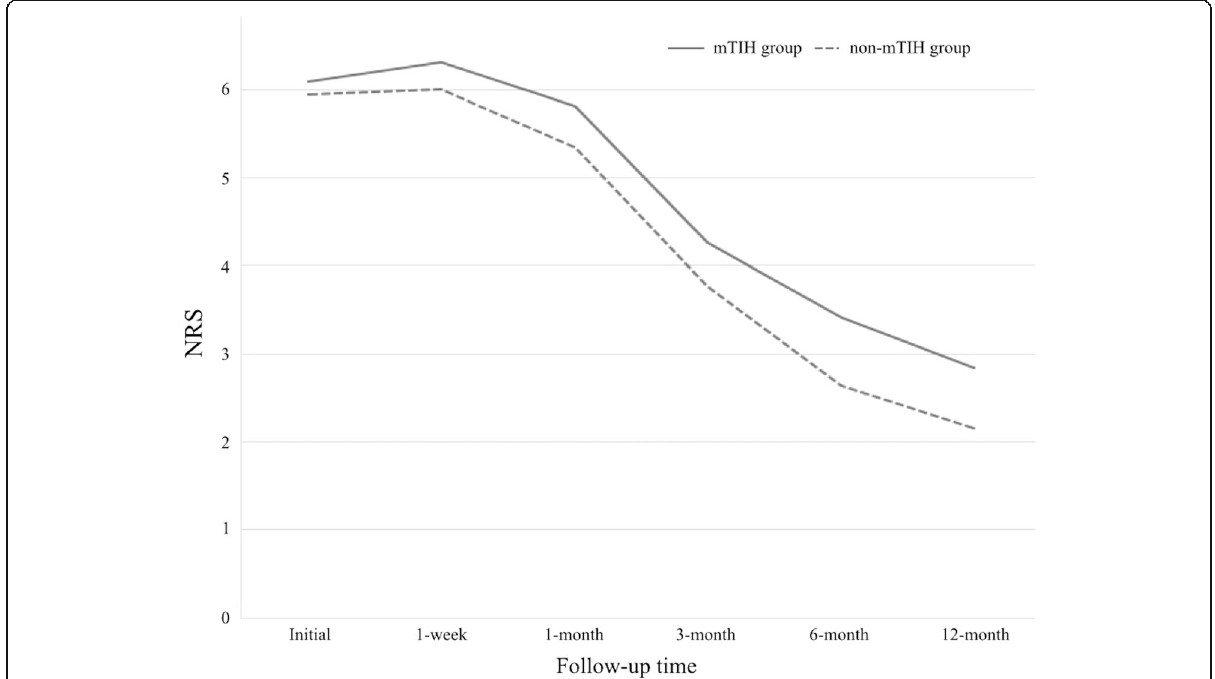
Fig. 2 Mean numeric rating scale (NRS) scores of both groups. The difference in NRS scores between mTIH groups and non-mTIH group was statistically significant (95% confidence interval, 0.11 to 1.14; p < 0.05,